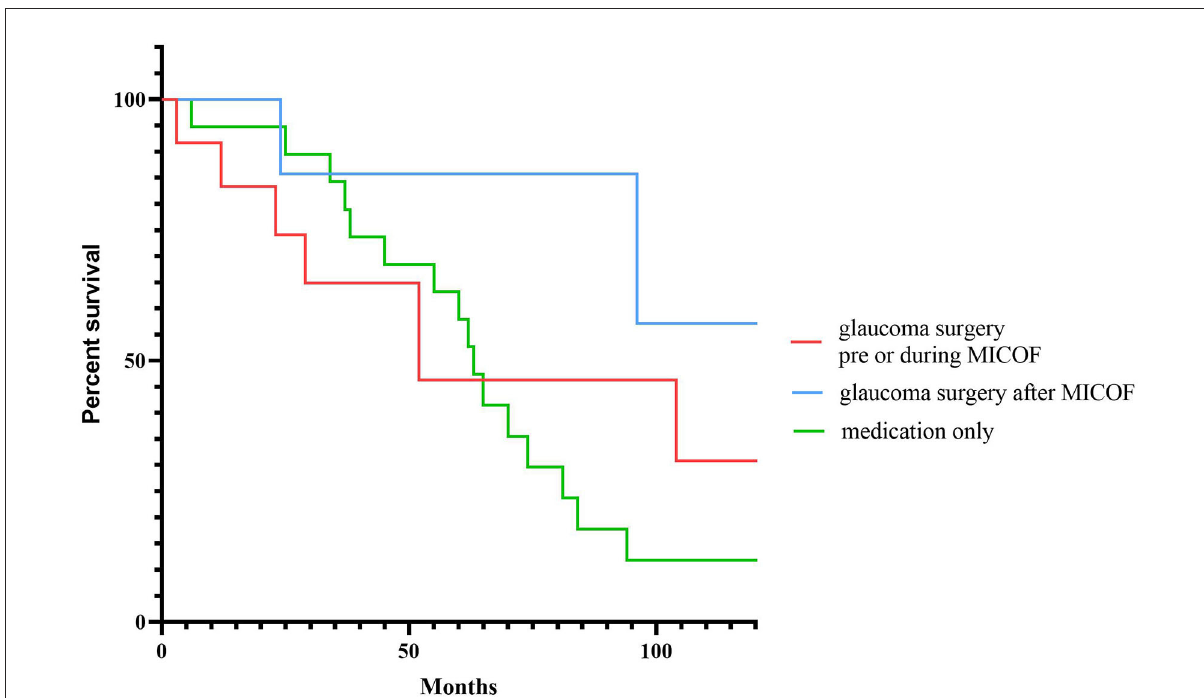
FIGURE1 The Kaplan–Meier survival curve for visual field loss to compare the timing of glaucoma surgery and